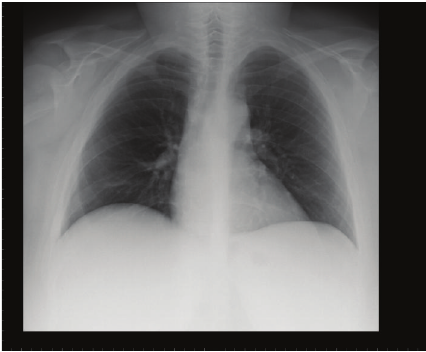
Figure 2: Preoperative chest